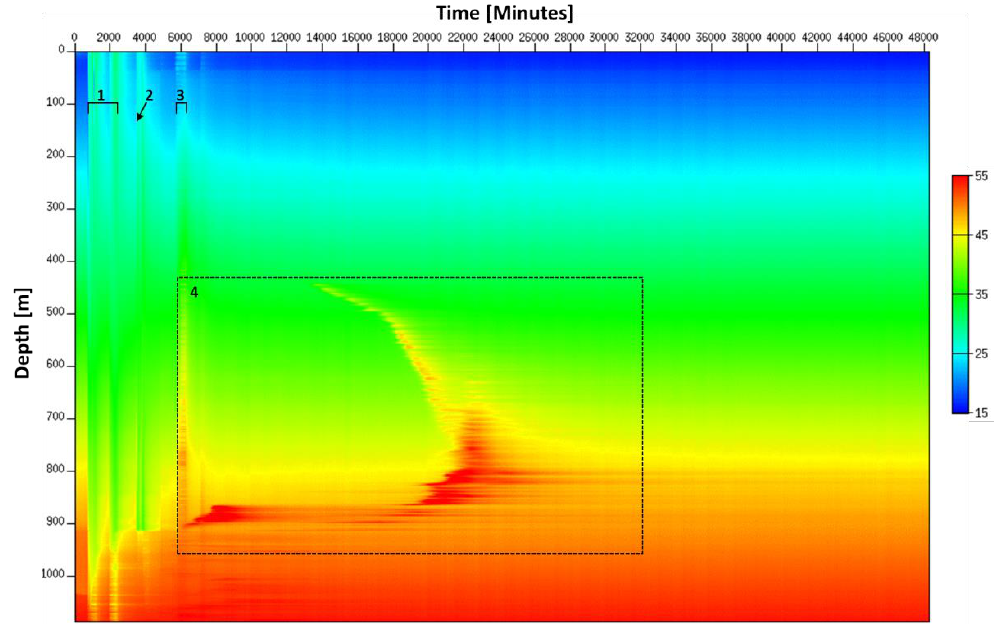
Figure 15. Heat map obtained during well completion where the gravel packing is denoted by 1, the cement injection by 2, the gas lift operation by 3 and the cement curing process by 4.